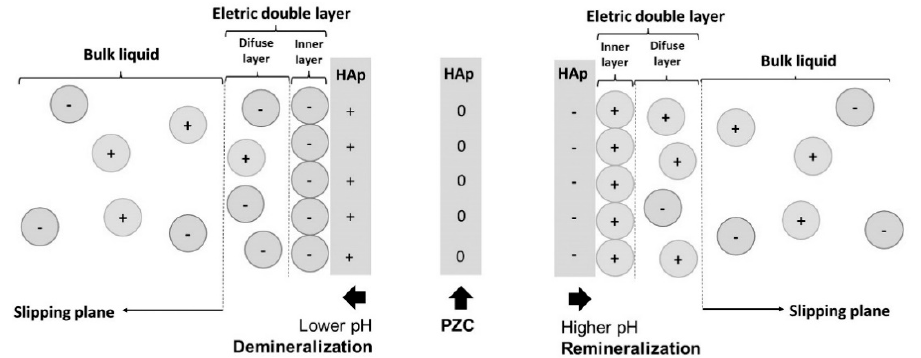
Figure 4. Representation of the electric double layer on the hydroxyapatite surface.